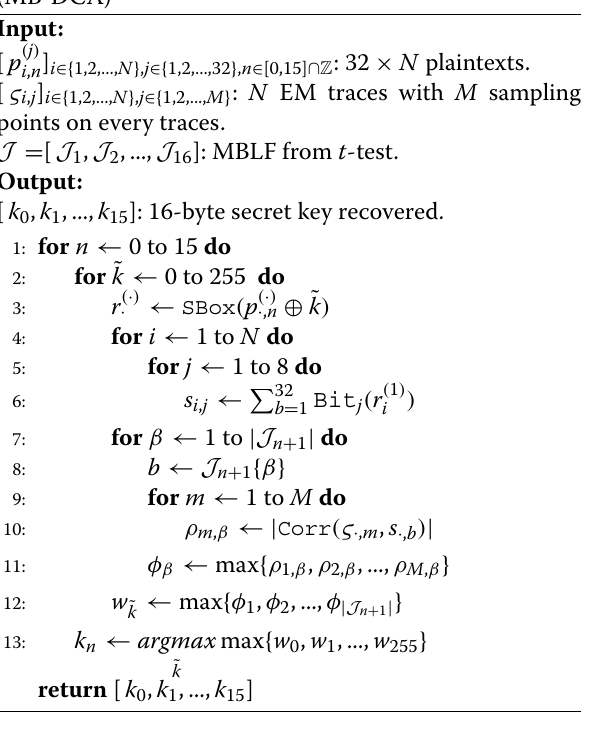
Algorithm 1 Multi-Bit Decision Combinational Analysis